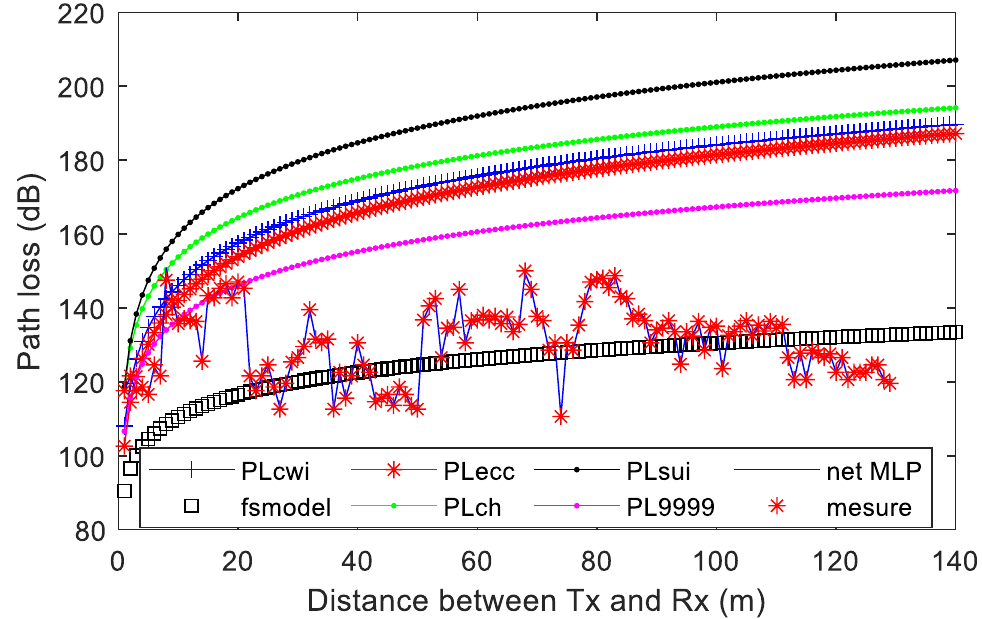
Figure 17. Comparison between empirical models and MLP (with three hidden layers) for Dataset 11.